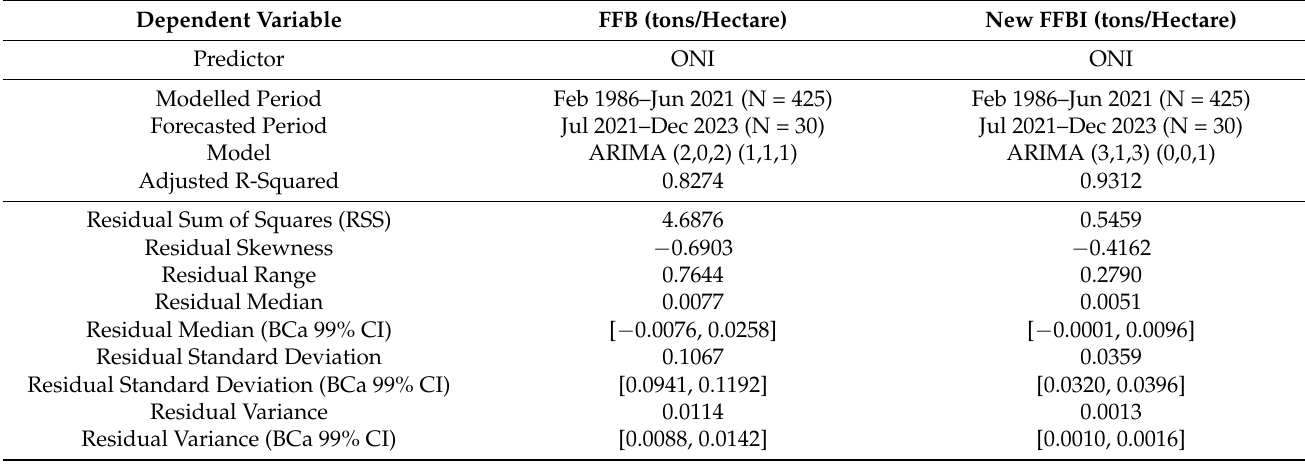
Based on the statistical assessment of the FFB and FFBI time series model (Table 6), the FFBI model (Appendix F) has an adjusted R-squared of 0.9312, which is significantly higher than the FFB model (Appendix E) with adjusted R-squared of 0.8274 only. Compared to the FFB model with residual sum of squares (RSS) of 4.6876, the FFBI model has much lower RSS at 0.5459 only. The FFBI model also has a lower median residual (0.0051) than the FFB model (0.0077). Other than that, residual of the FFBI model has lower skewness, range, standard deviation and variance compared to the FFB model. Table 6. FFB and FFBI time series forecasting models’ summary with residual analyses using descriptive and inferential statistics at α =